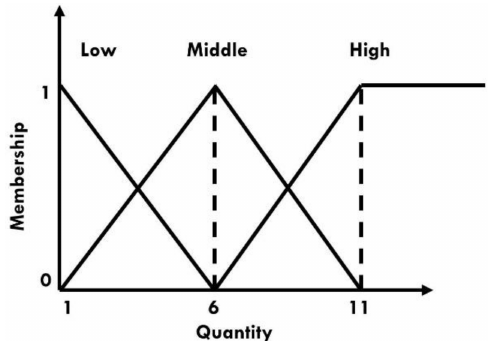
Figure 1. Membership functions of 3-linguistic